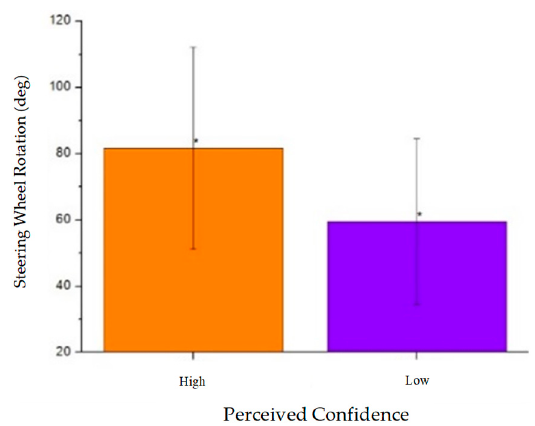
Figure 12. Oscillations measured in the third task for “confidence” subgroups.